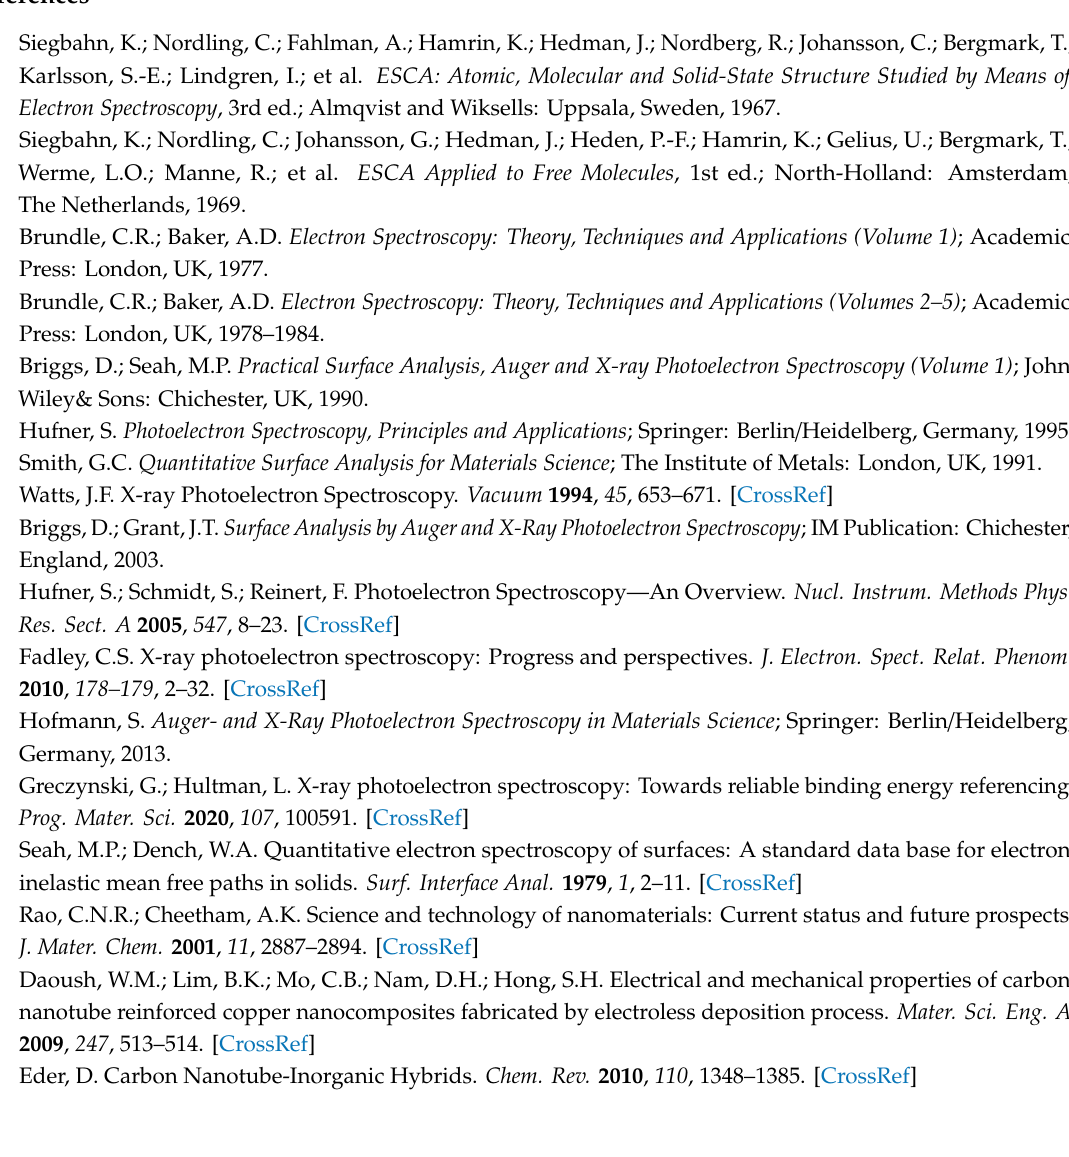
Figure S1: a schematic illustration of the experimental setup for growing of the radial-oriented aligned MWCNTs, Figure S2: a schematic illustration of the experimental setup for synthesis of the WC 1-x / MWCNTs nanocomposite, Figure S3: The processing stages